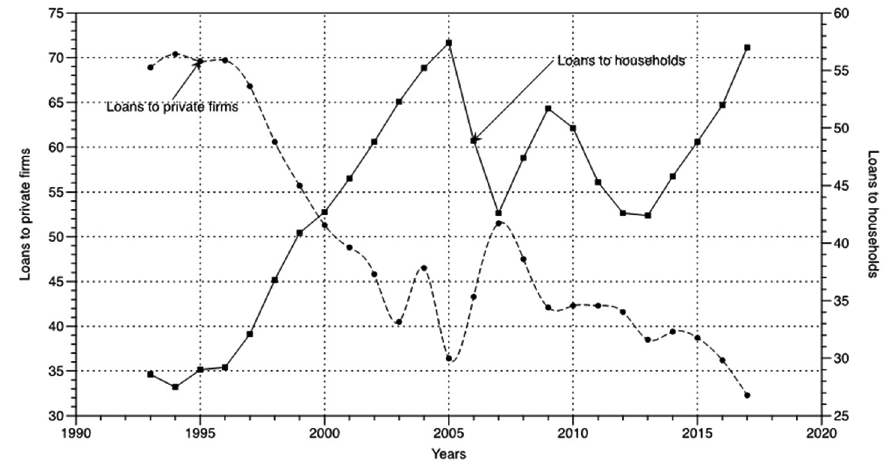
Figure 3. Credit structure (% share in total loans) in Croatia 1990−2017 (source: Croatian National Bank Statistical Database